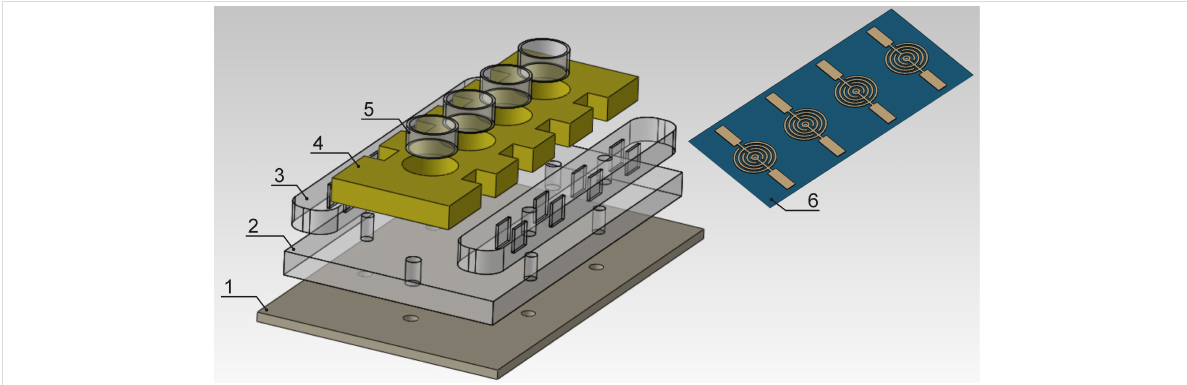
Figure 1: Structure diagrams of the electrical measurement cell and electrodes. Measurement cell consists of the following parts: a corps (1), an inter- layer (2) with push-in contacts (3) and a sealing rubber mask (4) with replaceable plastic cylinders (5). The complete sample (6) consists of four elec- trodes, which allow four independent measurements to be consistently performed for solutions of different concentration or chemical